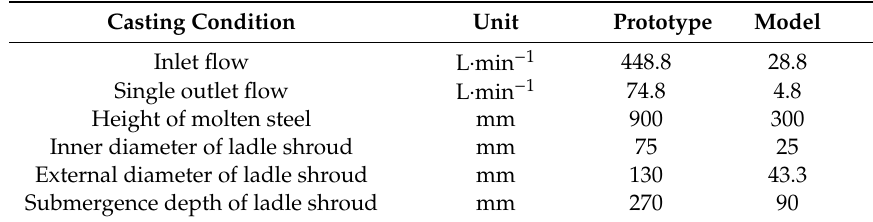
Table 3. The comparison between the main parameters of the prototype and the model. Casting Condition Unit